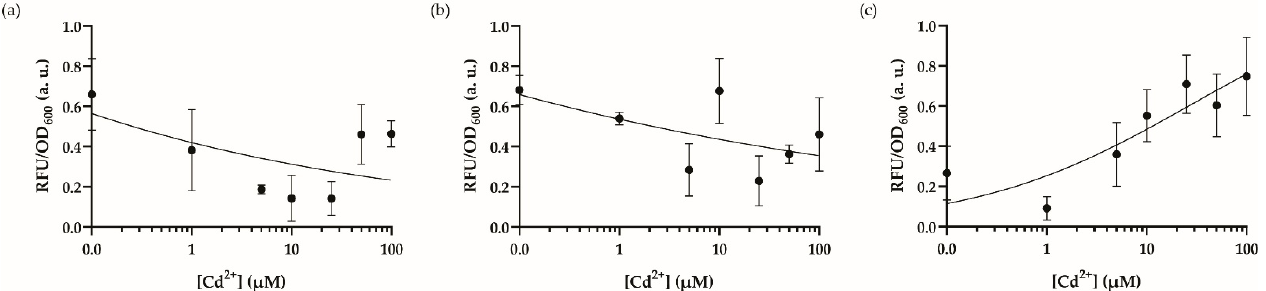
Figure 2. Dynamic range analysis of the engineered cadmium biosensor in different media. The dynamic range analysis of the recombinase-based cadmium sensor in ( a ) LB medium, ( b ) HMM medium, ( c ) MOPS minimal medium. Cultures were induced in 96-well plates with cadmium ion concentrations from 0–100 μ M and incubated for 18 h at 30 °C in a stable incubator. The fluorescence intensity of each group was compared with each other and 0–1 normalized according to the formula stated in the Materials and Methods section. Data were visualized with mean ± standard error mean (SEM) in each graph. At least three biological replicates were used for each analysis. The point on the y -axis (0.0) represents the uninduced condition/background signal.